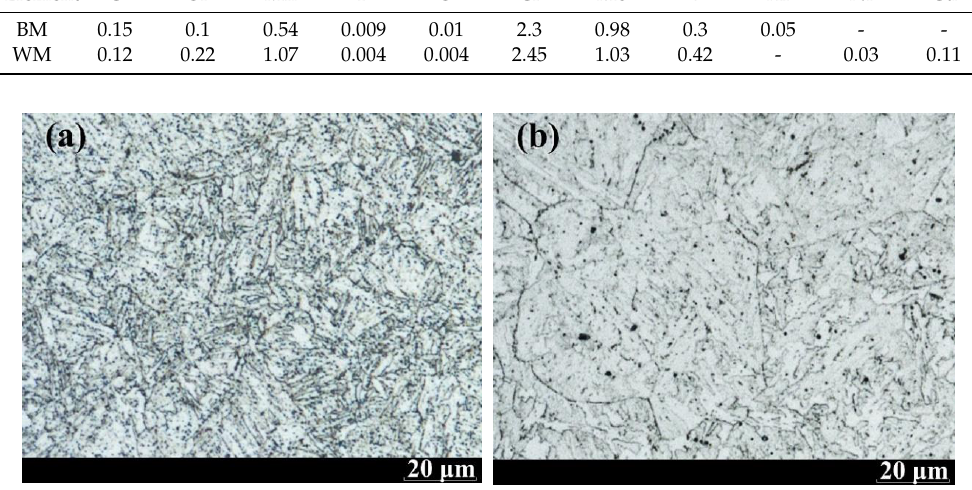
Table 1. Chemical composition of BM and WM (wt.%).